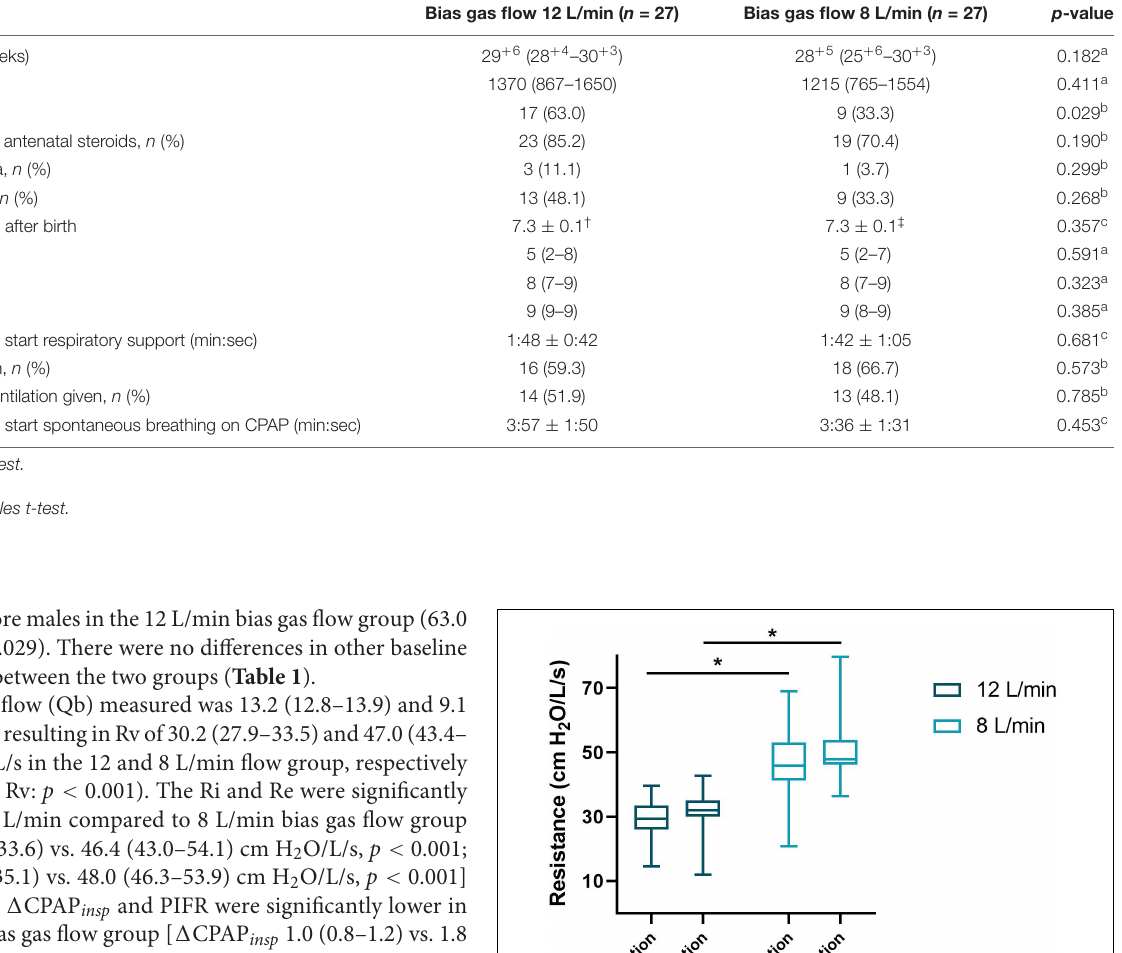
TABLE 1 | Patients’ characteristics.